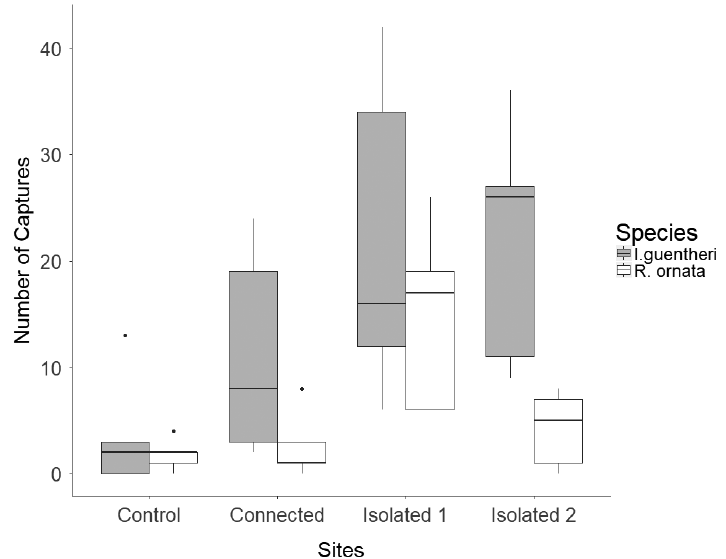
Figure 2. Comparison of the number of captures of Rhinella ornata and Ischnocnema guentheri in the study sites. The median, first and third quartile, minimum-maximum range and outliers of capture rates are